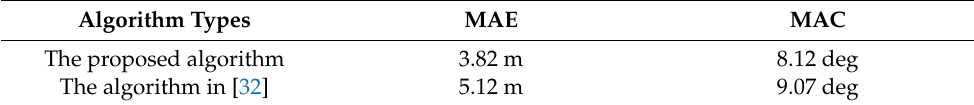
Figure 7. Comparison of rudder angle: proposed algorithm and control method in [32].